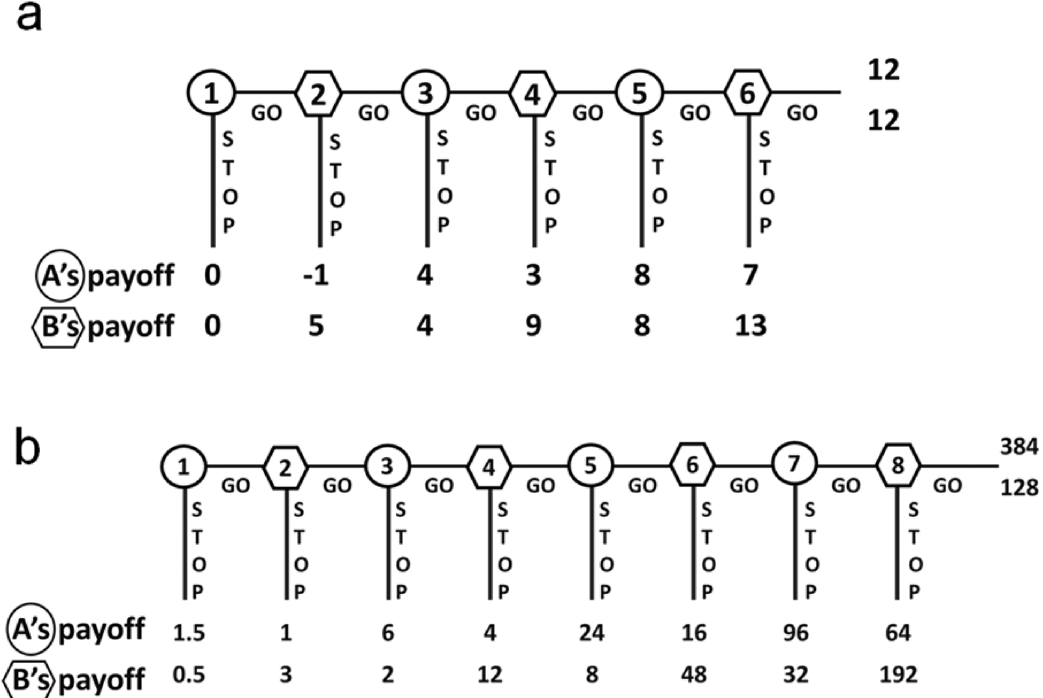
Fig 1. Typical Centipede games. (a) Linear Centipede game; (b) Exponential Centipede game. Decision nodes are numbered in circles for Player A and in hexagons for Player B.